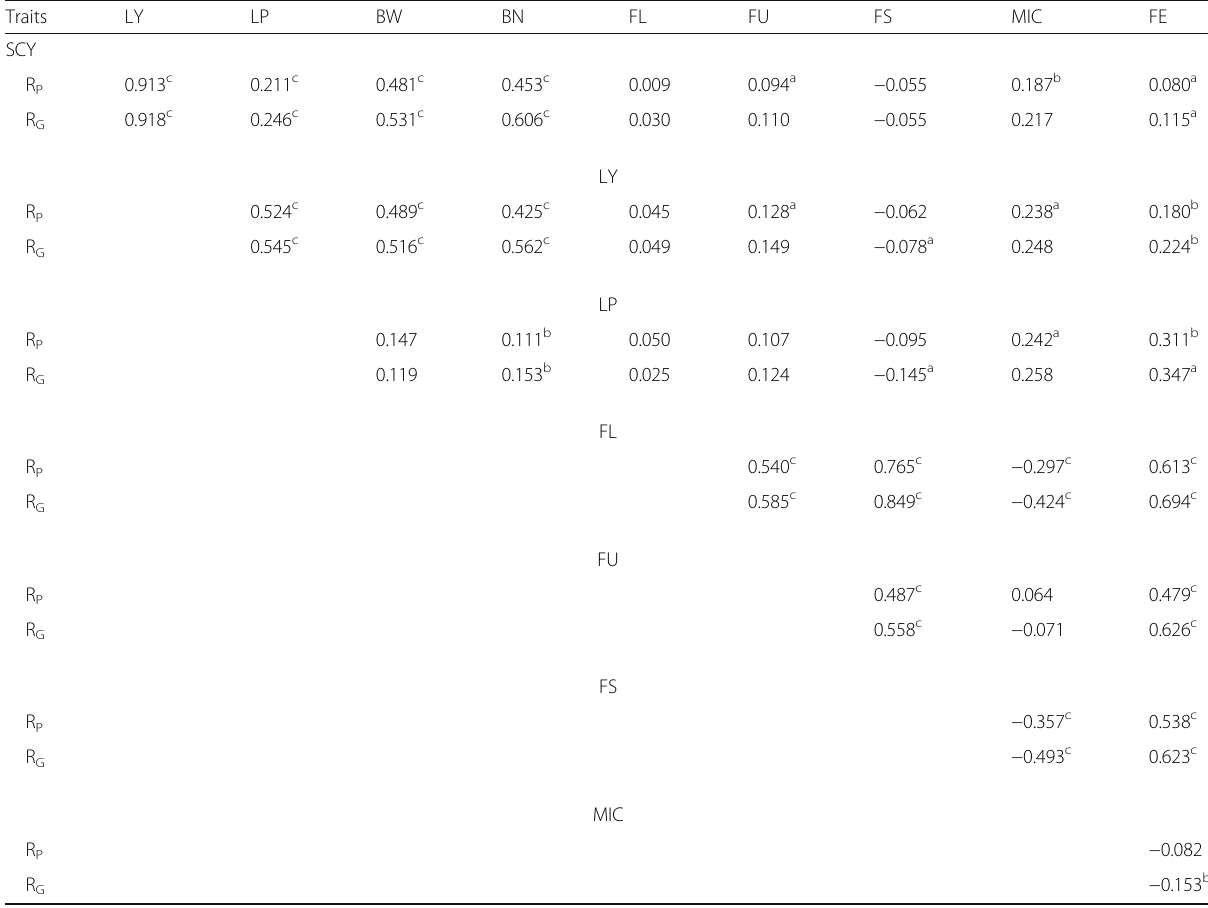
R P phenotypic correlation coefficient, R G genetic correlation coefficient a , b and c denote significant differences at 0.1, 0.05 and 0.01 levels,